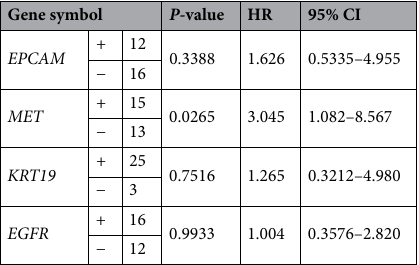
Table 2. Prognostic value of epithelial-related markers in CTCs.